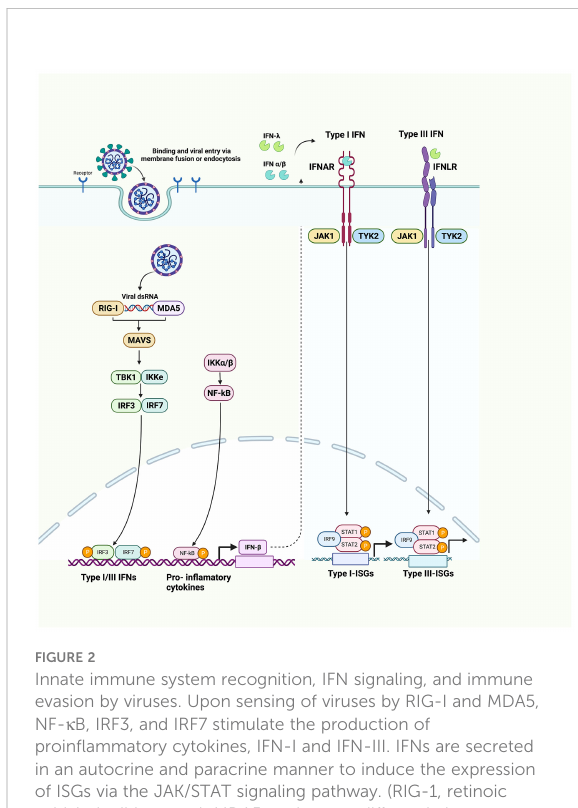
FIGURE 2 Innate immune system recognition, IFN signaling, and immune evasion by viruses. Upon sensing of viruses by RIG-I and MDA5, NF- k B, IRF3, and IRF7 stimulate the production of proin fl ammatory cytokines, IFN-I and IFN-III. IFNs are secreted in an autocrine and paracrine manner to induce the expression of ISGs via the JAK/STAT signaling pathway. (RIG-1, retinoic acid-inducible gene I; MDA5, melanoma differentiation- associated gene 5; NF- k B, nuclear factor- k B; IRF3, interferon regulatory factor 3; IRF7, interferon regulatory factor